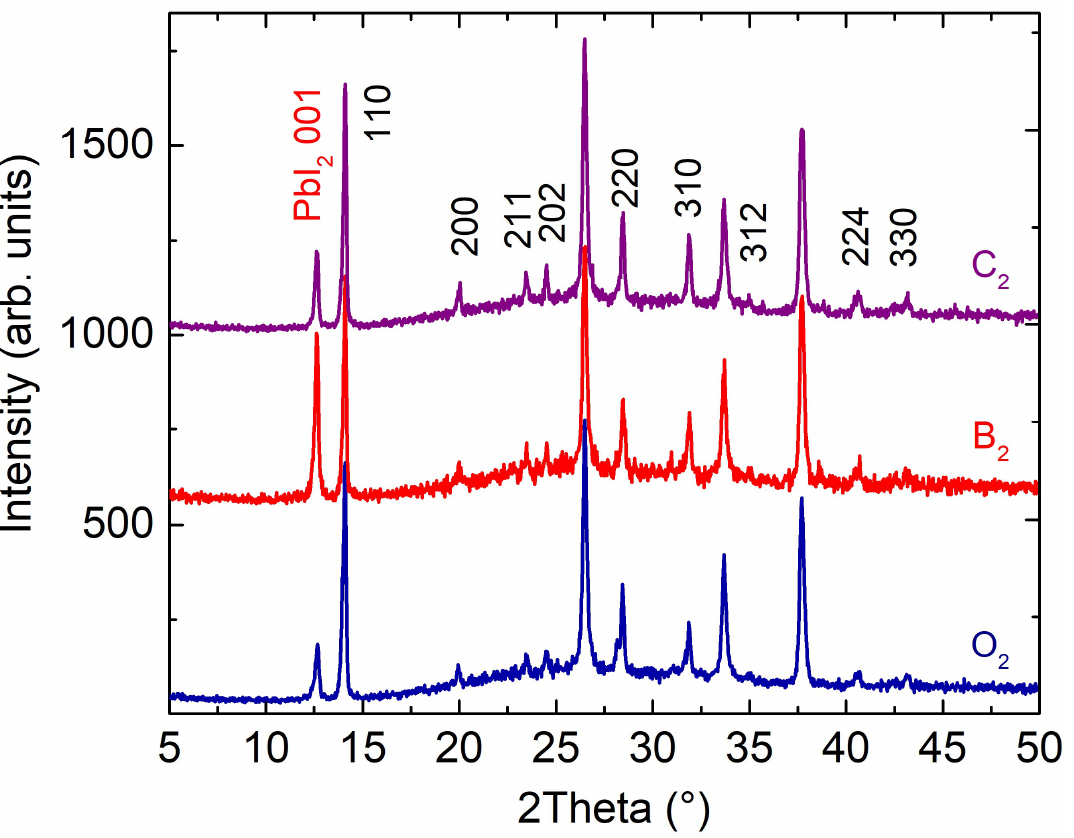
Figure 4. XRD patterns of films after the second dipping treatment in MAI. Table 2. Integrated areas of 100 of PbI 2 and of 110 of MAPI and their ratio.